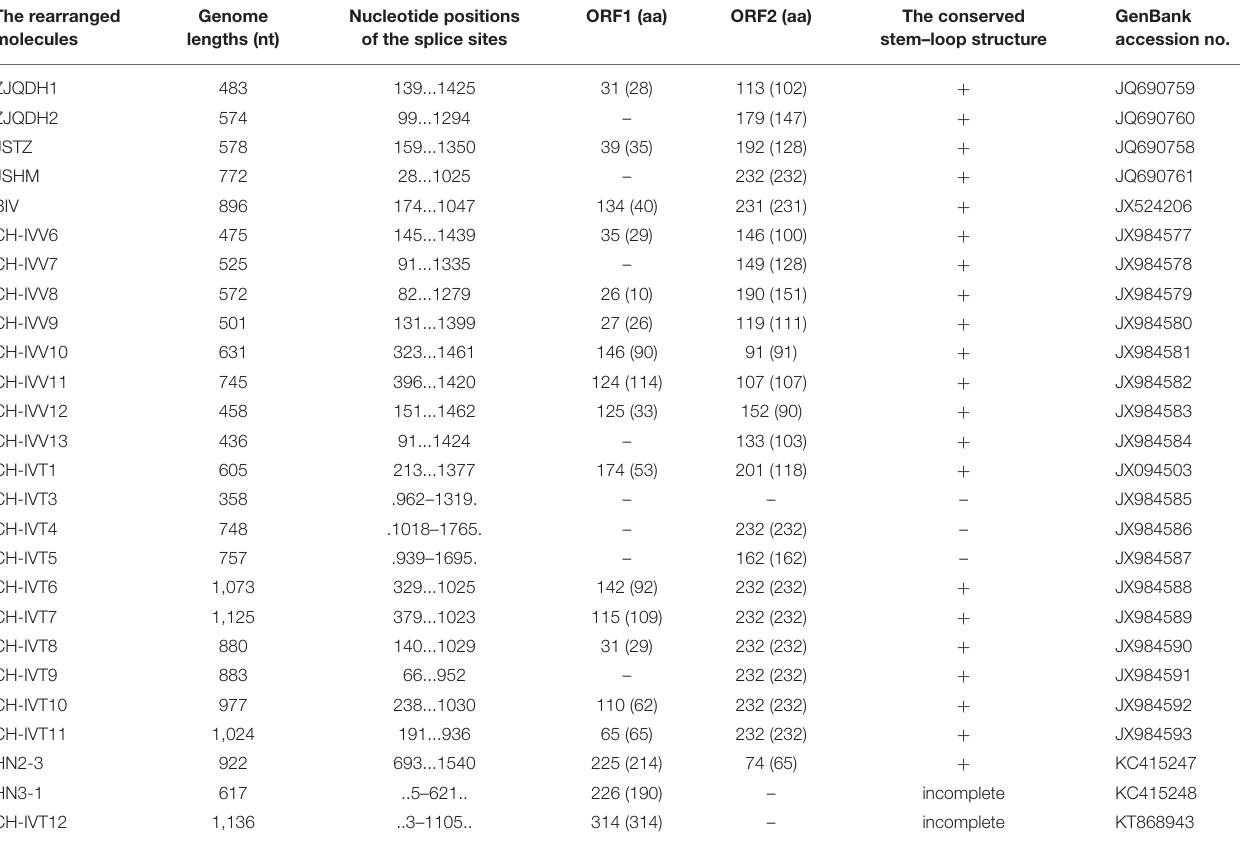
TABLE 1 | Genome characteristics of the rearranged molecules from serum samples and PK15 cells infected with full-length PCV2 genomes. The rearranged Genome Nucleotide positions ORF1 (aa) ORF2 (aa) The conserved molecules lengths (nt) of the splice sites